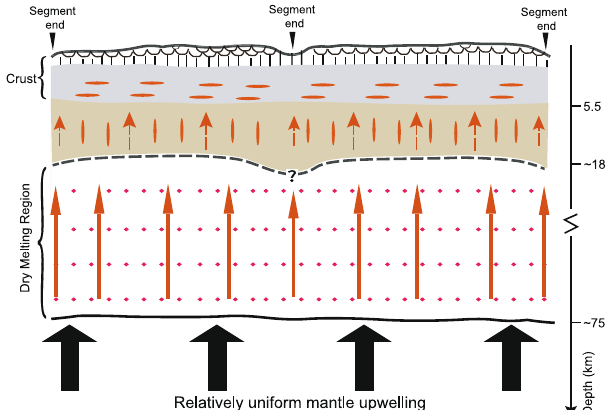
Fig.6|Schematicdiagram. Schematicdiagramshowingrelativelyuniformcrustal accretionand two-dimensionalsheet-likemantleupwelling.Theblackthickarrows represent deep mantle upward fl ow. The black curve represents the start of dry melting. The red solid arrows represent melt migration in the dry melting region. The grey dashed curve represents the top of the melting zone. The red dashed arrows represent melt migration below the mantle-crust boundary. The depth of thetopofthedrymeltingregionisfromref.80andthepresenceofmeltsillsinthe lower crust is determined in ref. 81. In this model, the melt is not focused to segment centres at the base of the lithosphere 19,20 , but migrates upward